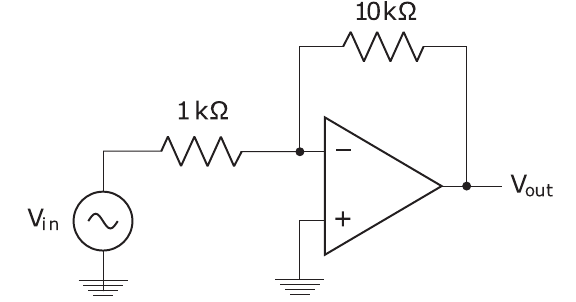
FIG. 2. A circuit diagram of the inverting amplifier circuit used in the TAPS interviews. The students were given a handout with this circuit diagram at the beginning of the activity. The values of the feedback and input resistors were written. Purposefully missing are the values of the power rails (initially set at (cid:2) 10 V), and the capacitors from each power rail to ground (100 pF)